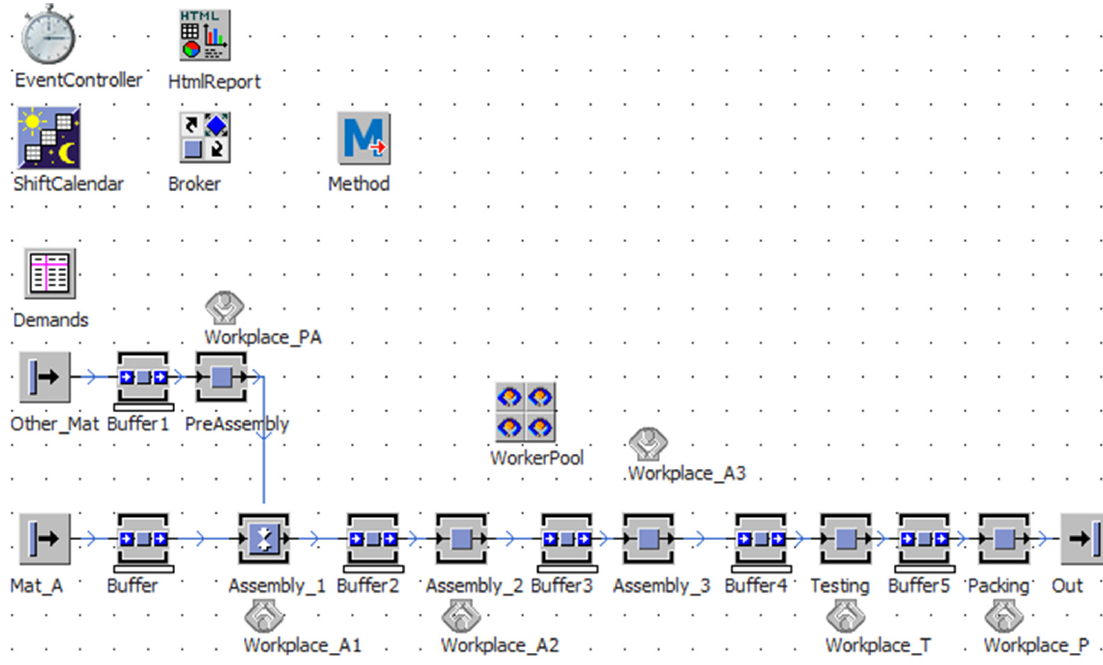
Figure 8. Simulation model of the assembly line—improved state.